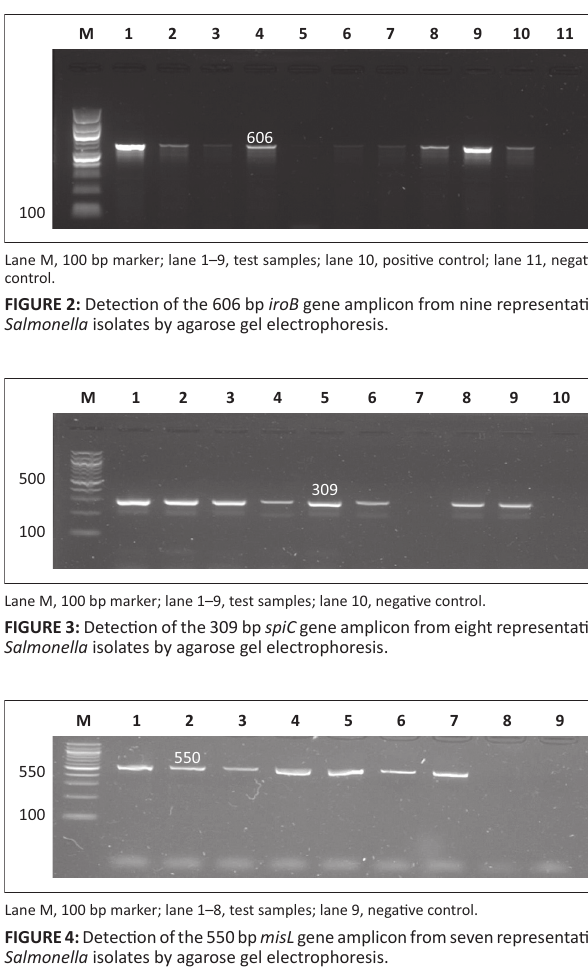
FIGURE 1: Detection of the 284 bp invA gene amplicon from eight representative Salmonella isolates by agarose gel electrophoresis.